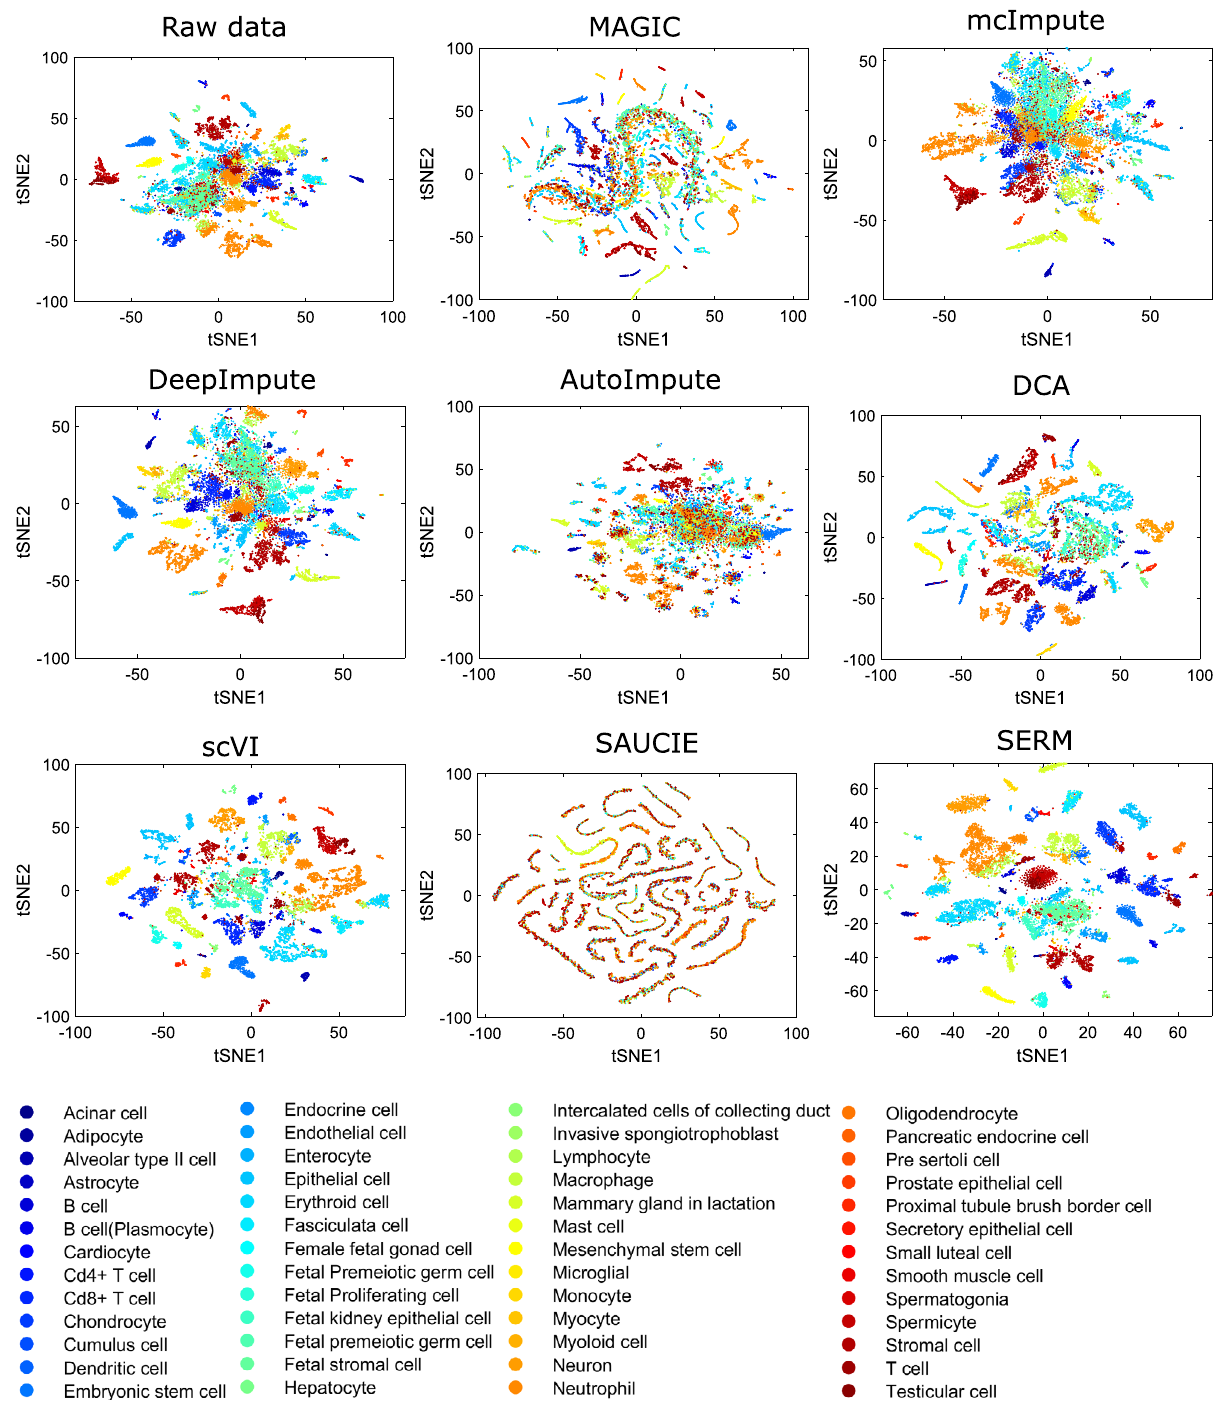
Fig. 7 | t-SNE visualizations of the raw and imputed data by eight different methods for the MCA data. Source data are provided as a Source Data fi